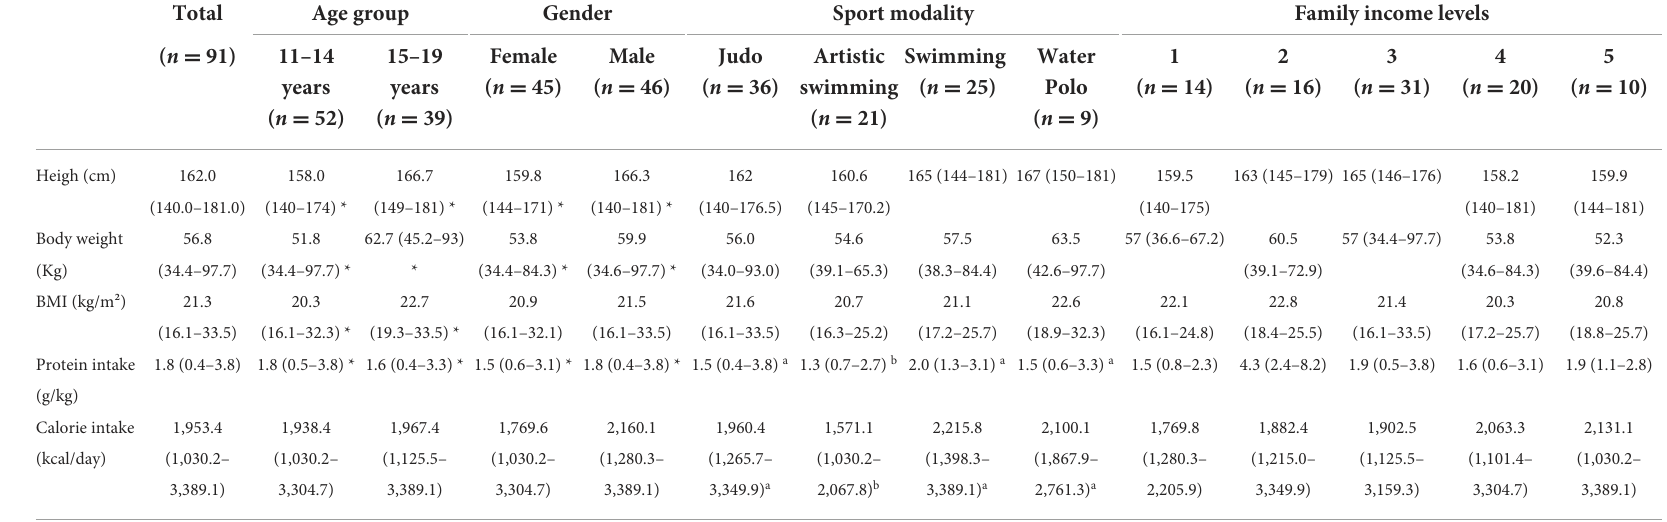
TABLE 2 Anthropometric data, energy intake and protein intake of the adolescent athletes participating in the research, categorized by age group, gender, sport modality and monthly family income levels. Total Age group Gender Sport